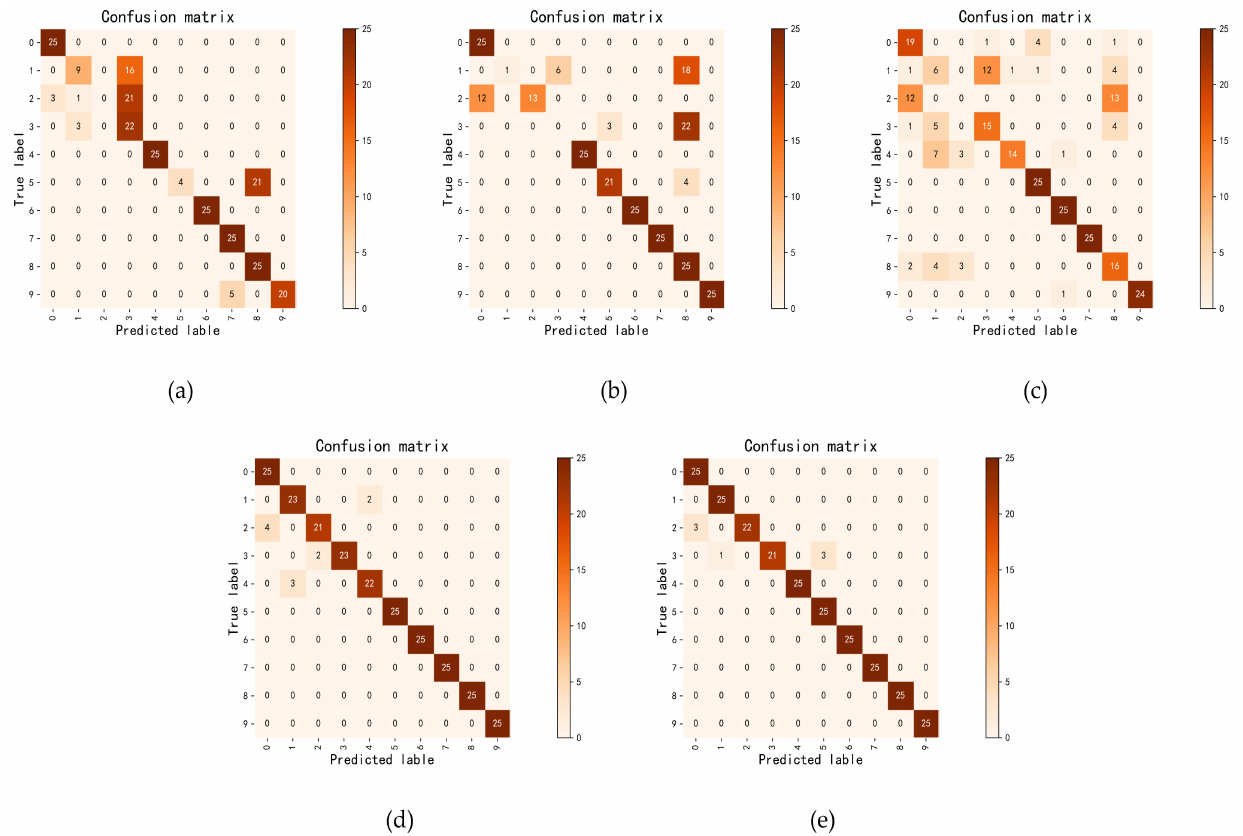
Figure 9. Confusion matrix from C-A test results. Confusion matrix of ( a ) WDCNN, ( b ) CapsuleNet, ( c ) DANN, ( d ) DeepJDOT, and ( e )